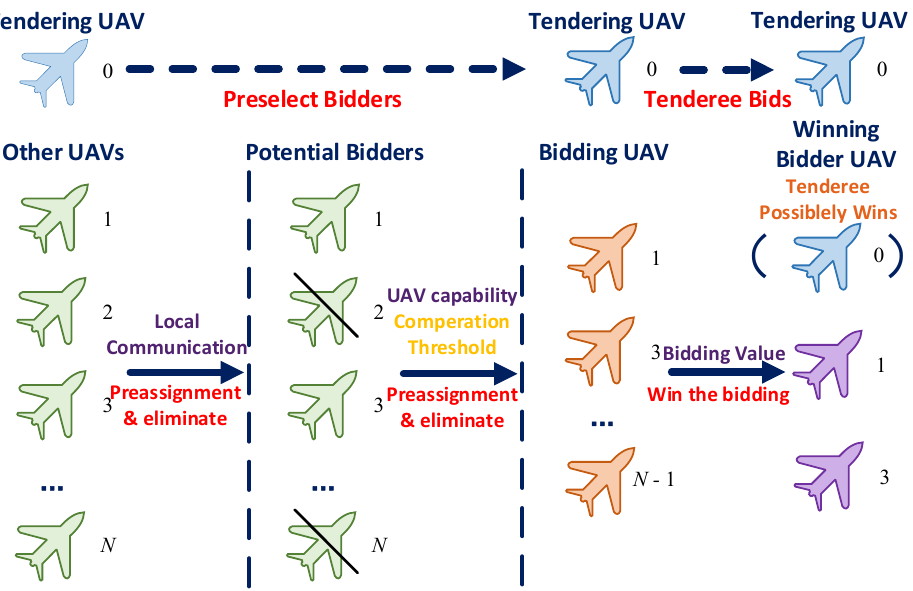
Figure 4. The determination mechanism on cooperators.